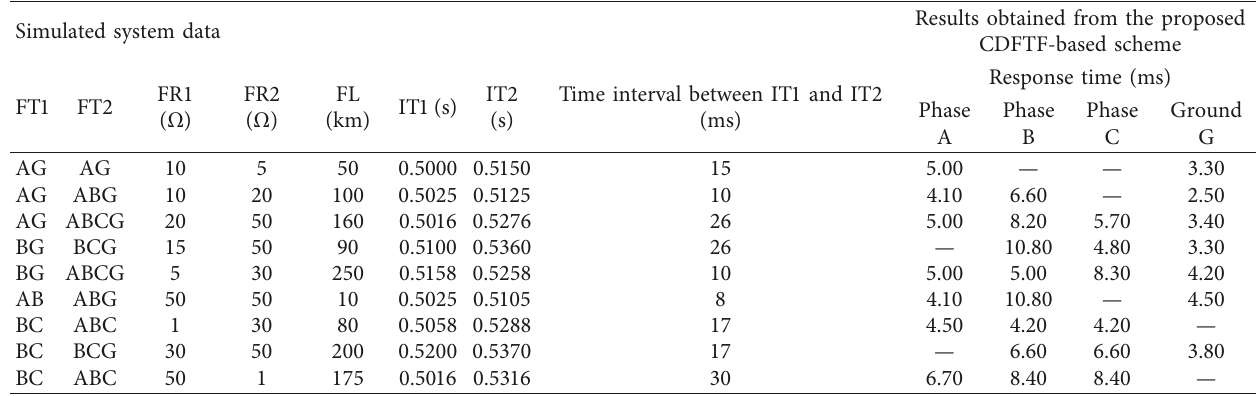
Figure 7: Performance during AG fault at 50km, FIA � 45 ° , and FR � 50 Ω : (a) 3-phase voltage waveform; (b) 3-phase current waveform; (c) output of Table 8: Simulation results for evolving faults.